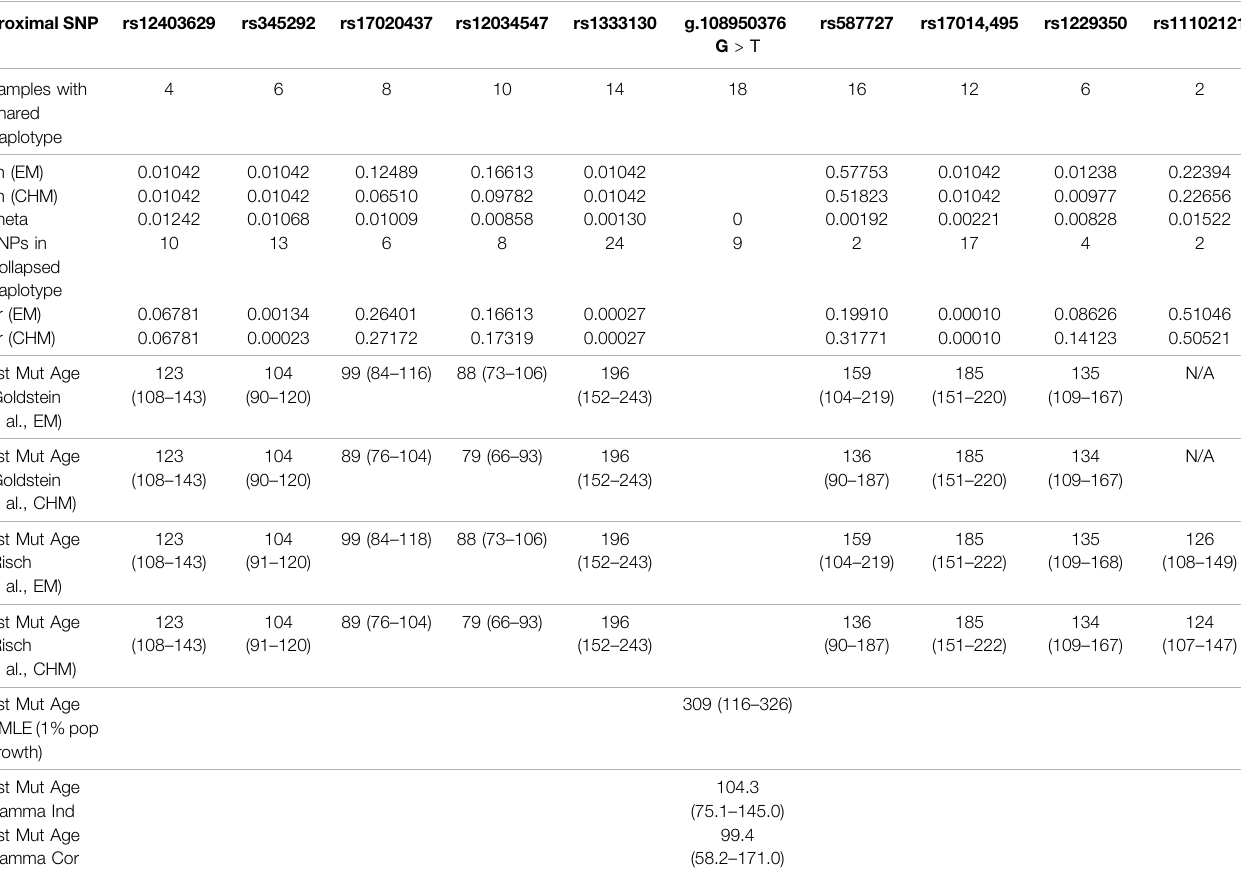
TABLE 2 | Mutation age estimates in generations of the c.75C > A mutation in the South Asian population by the methods described by Goldstein et al., Risch et al., by Bayesian estimation, and Gamma estimation. Fn(EM): frequency of the observed haplotype in the normal population as estimated by the expectation-maximization method, Fn(CHM): frequency of the observed haplotype in the normal population as estimated by the composite haplotype method, Theta: estimated recombination frequencyofthehaplotypeblocktothemutation, Pr(EM):probabilityofthehaplotype intheaffectedfamily haplotypes asestimated bytheEMmethod, Pr(CHM): probability of the haplotype in the affected family haplotypes as estimated by the CHM method, Gamma Ind: estimation from segment lengths assuming an ‘ independent ’ genealogy, Gamma Cor:Assuming acorrelated genealogy.The c.75C > Amutationisalternately referredtoasNC_000001.11:g.108950376G > Tfor consistencywith other